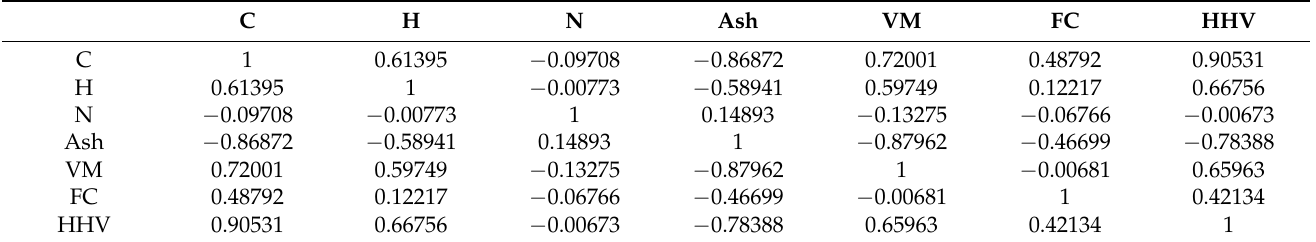
Table 2. Pearson’s correlation coefficients between sample parameters. Here, C, H, and N are the features of ultimate analysis: carbon, hydrogen, and nitrogen, respectively. The features of proximate analysis are denoted as Ash—ash; VM—volatile matter; and FC—fixed carbon.